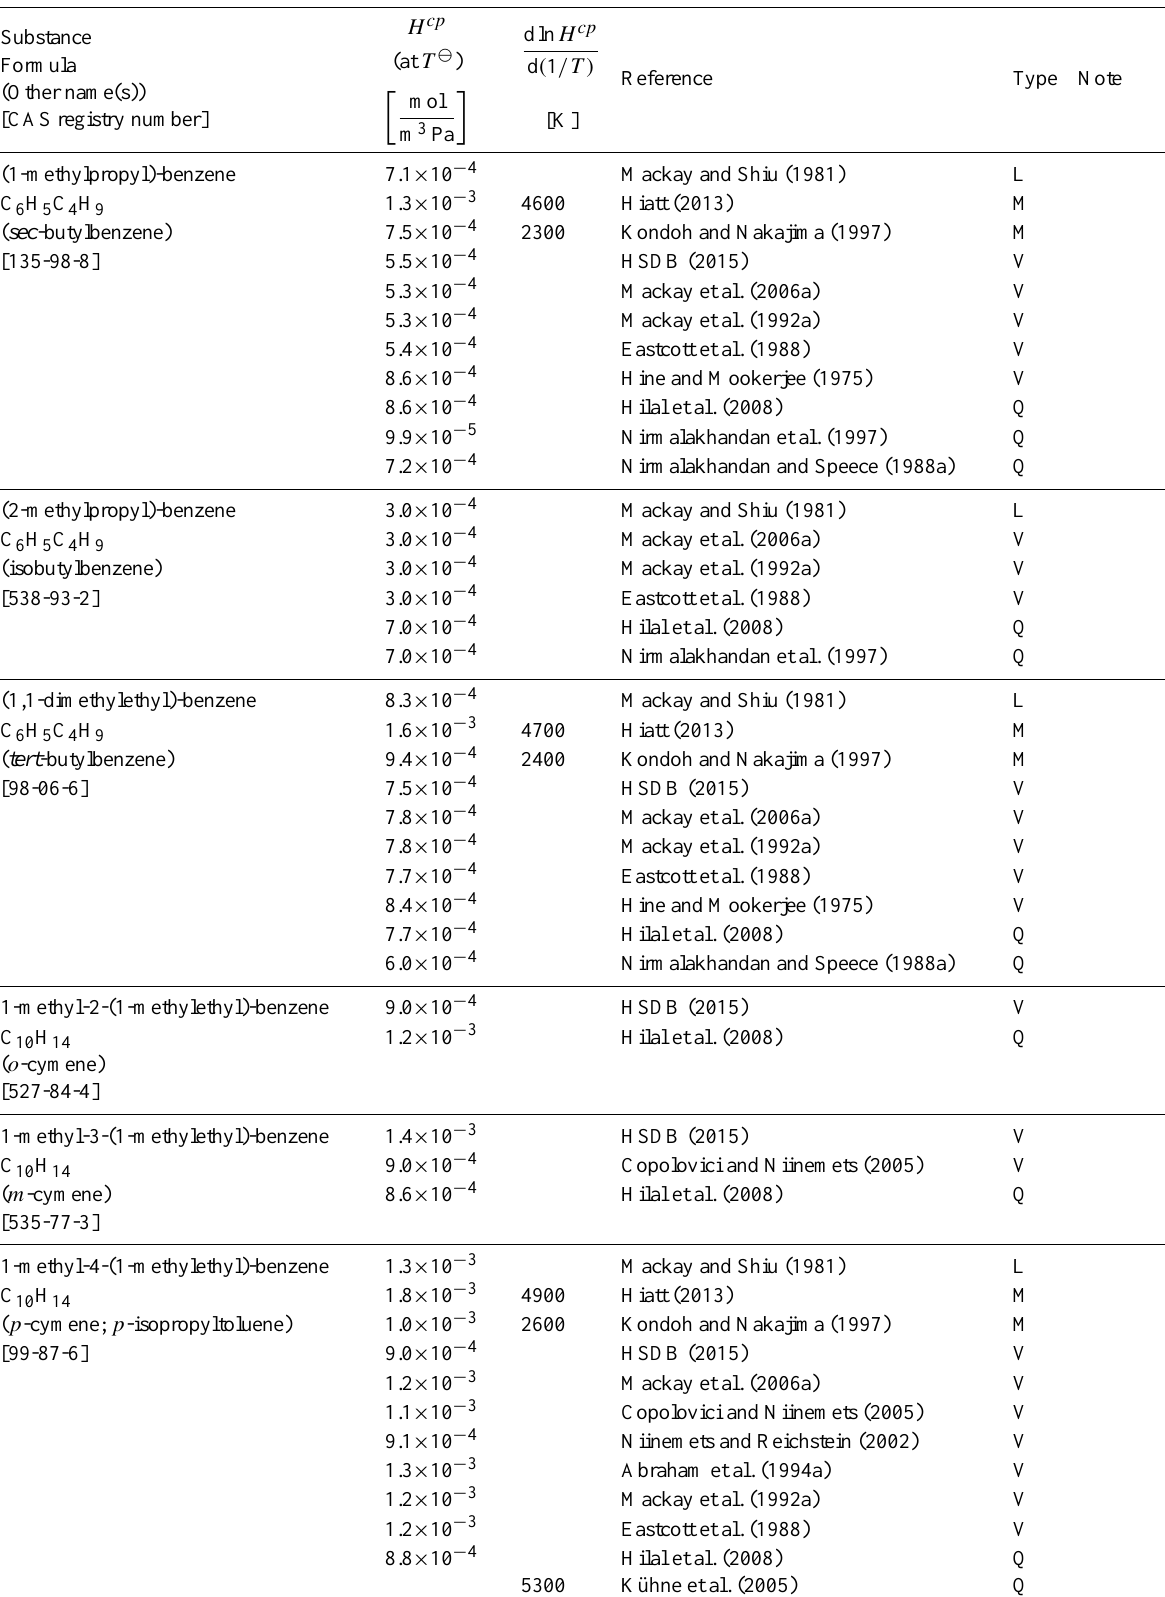
Table 6: Henry’s law constants for water as solvent